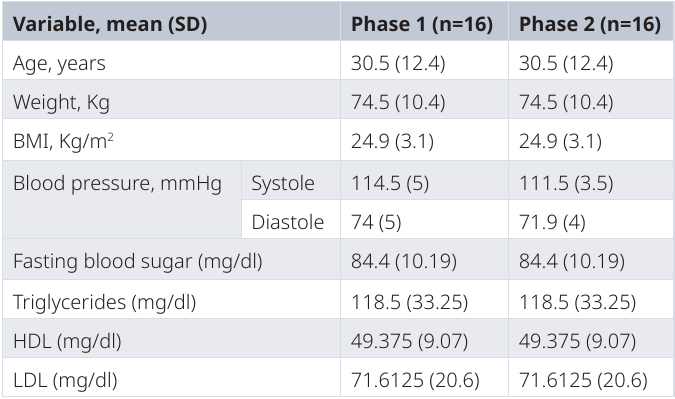
Table 1. Baseline demographic and clinical characteristics of the 16 enrolled participants in the